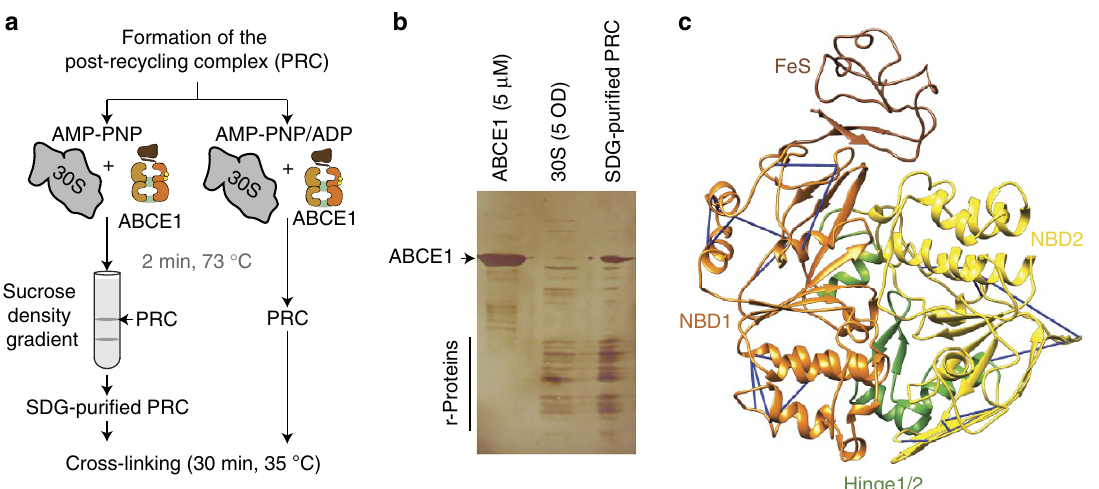
Figure 1 | Lysine-specific cross-linking of ABCE1 bound in the post-recycling complex (PRC). ( a ) A stably arrested and homogeneous population of PRC was isolated from sucrose density gradients (SDG) after reconstitution from purified components at physiological temperatures and in the presence of non- hydrolysable AMP-PNP. ( b ) Sample quality was analysed via SDS–polyacrylamide gel electrophoresis (silver-stain). Alternatively, PRCs were reconstituted under identical conditions from isolated components without any additional purification via SDG. As control, the sample was prepared in the presence of ADP, which does not promote a stable arrest of ABCE1 on the small ribosomal subunit. ( c ) Lysine specific cross-linking with DSS resulted in a distinct set of intra cross-links within ABCE1. Cross-links shown here are those of the SDG-purified samples (closed model).